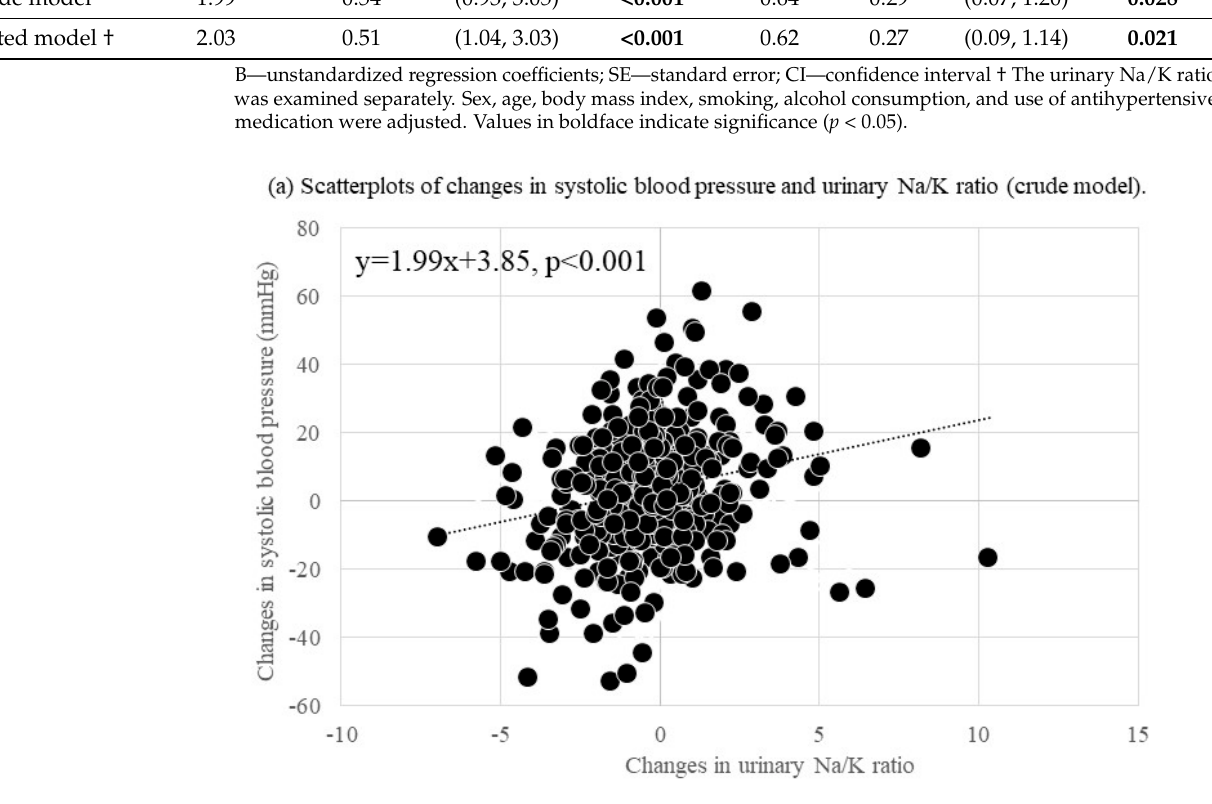
Figure 1. Scatterplots of changes in blood pressure and the urinary Na/K ratio 3.3. Association between Changes in The Urinary Na/K Ratio and BP Resulting from The Use of Antihypertensive Medication Table 3 and Figure 2 show the results of the subgroup analyses. In the non-user of antihypertensive medication group, a change in the urinary Na/K ratio was positively as- sociated with changes in SBP in both the crude (B=2.57; 95% CI=1.05, 4.09; p =0.001) and the adjusted models (B=2.39; 95% CI=0.93, 3.85; p =0.001) and DBP in both the crude (B=1.14; 95% CI=0.19, 2.08; p =0.019) and the adjusted models (B=0.99; 95% CI=0.08, 1.89; p =0.033). In the antihypertensive medication user group, although a change in the urinary Na/K ratio was positively associated with SBP change in both the crude (B=1.55; 95%